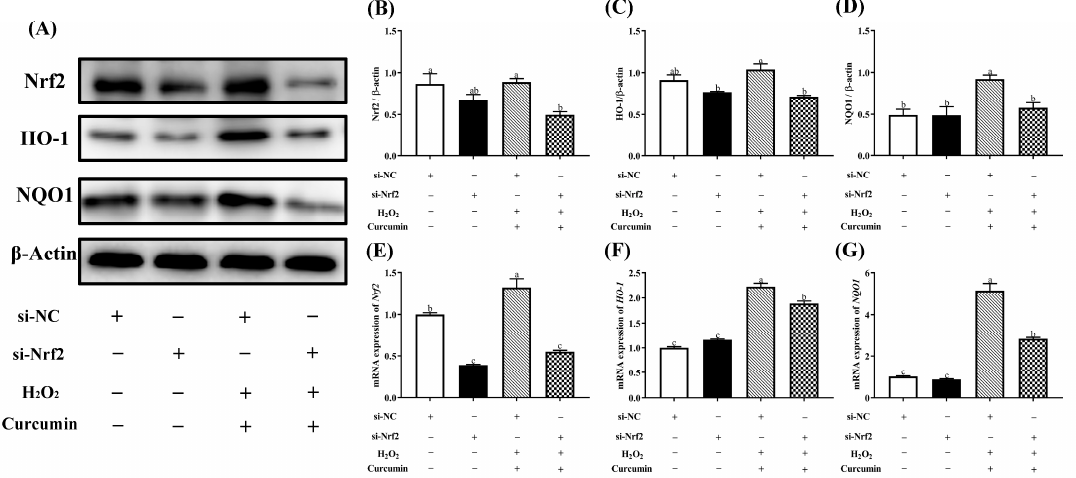
Figure 7. Silencing Nrf2 gene abolished the prevention made by curcumin. HTR8/SVneo cells transfected with siRNA against Nrf2 or control siRNA for 24 hours, followed by 24 h pre-treatment with 5 μ M curcumin, and then treated with 400 μ M H 2 O 2 for another 24 h. The bands ( A ) and relative protein expression of Nrf2 ( B ), HO-1 ( C ) and NQO1 ( D ) were measured by Western blotting. The mRNA expression of Nrf2 ( E ), HO-1 ( F ) and NQO1 ( G ) were measured by RT-PCR. Data are presented as the mean ± SEM ( n = 3). a, b, c Means with different letters are significantly different ( p < 0.05).